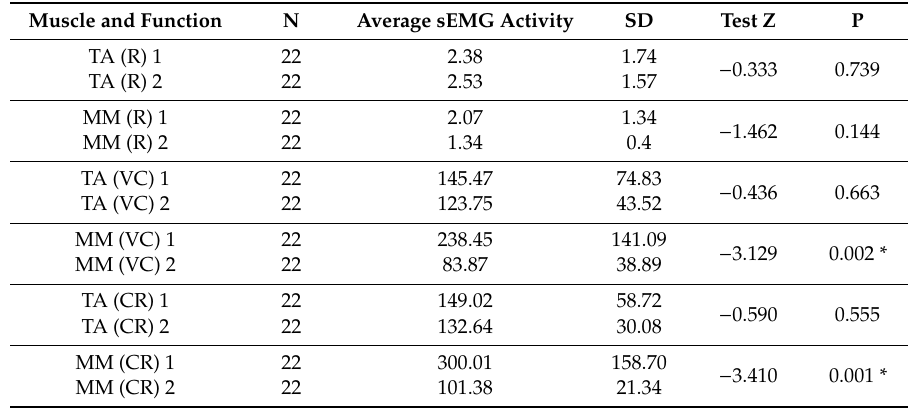
Table 1. Collective comparison of bioelectric activity of temporalis anterior muscle (TA) and masseter (MM) at rest (R), during maximum voluntary clenching (VC), and during maximum voluntary clenching with cotton rolls between teeth (CR) between sport climbers (1) and controls (2). Muscle and Function